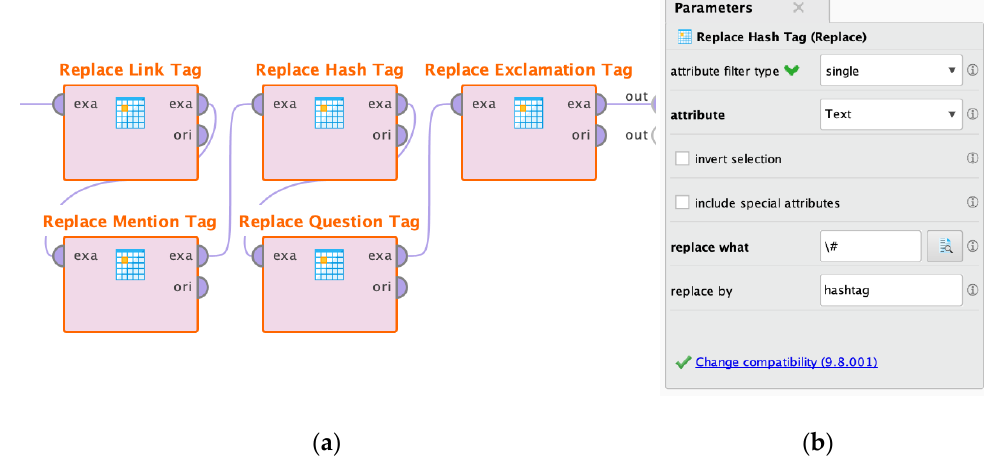
Figure 4. ( a ) Replace Tag operator that replaces special symbols to their corresponding words, and ( b ) the parameter section of the operator to input “replace what” and “replace by” values.